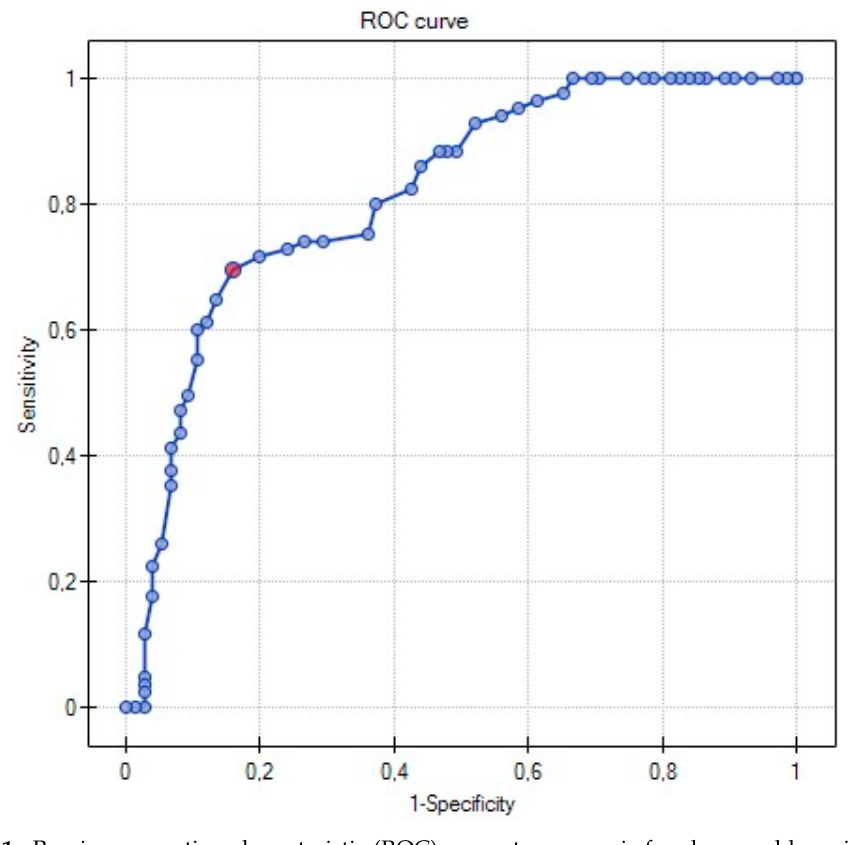
Figure 1. Receiver operating characteristic (ROC) presents prognosis for sleep problems in aging patients with T2DM. AUC, area under the curve.